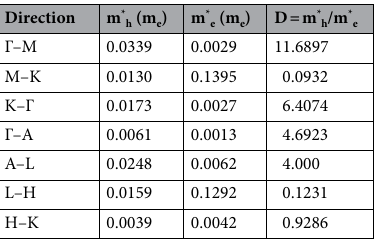
Table 1. Effective masses of holes (valence band maximum) and electrons (conduction band minimum) of Cu 2 SrSnS 4 along high symmetry